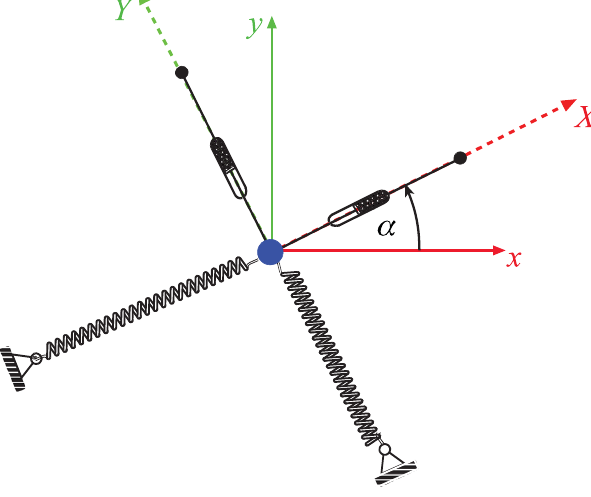
Figure 3. Mechanical model for each marker performing in-plane